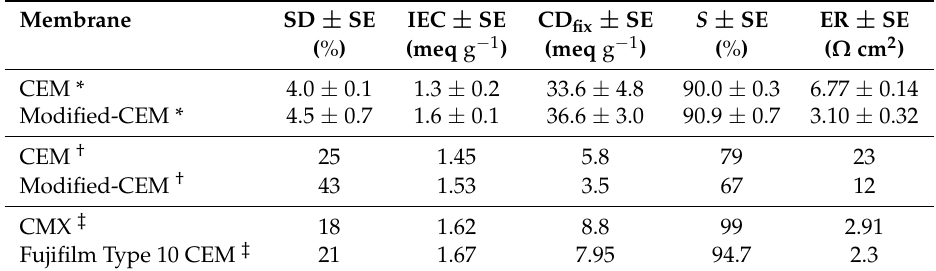
Table 3. Swelling degree (SD), Ion Exchange Capacity (IEC), Fixed charge density (CD fix ), Permselectivity ( S ), and Electrical resistance (ER) with standard error (SE, n = 3) of the synthesized CEM before and after modification. We also include reference values found in the literature [43,46], and values for two commercially available CEMs, an CMX and a Fujifilm Type 10 CEM [3,71]. Membrane SD ± SE IEC ± SE CD fix ± SE S ± SE ER ± SE ( % ) (meq g − 1 ) (meq g − 1 ) ( % ) ( Ω cm 2 ) CEM * 4.0 ±